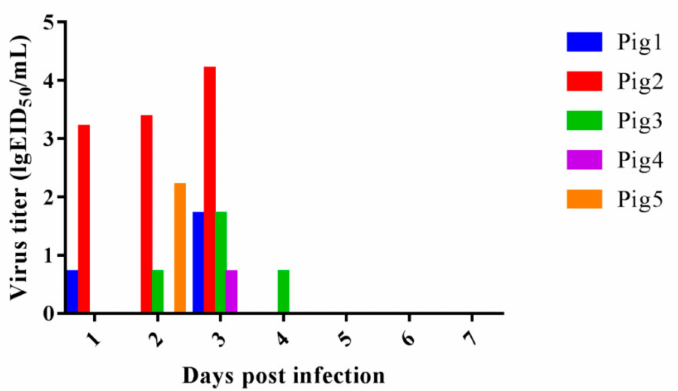
Figure 5. Virus shedding of H9N2 influenza virus in inoculated pigs. Thirteen healthy 3-week-old pigs were randomly divided into three groups. Of these, five pigs were intranasally inoculated with CK93 / 17 at a dose of 10 7 EID 50 in 1 mL as treatment group. Three pigs were intranasally inoculated with 1 mL PBS as control group. One-day post-inoculation (1 dpi), five pigs were housed with treatment pigs as a physical contact group. Nasal wash was collected from all pigs from 1 to 10 dpi and titrated in 9 to 11-day-old embryonated eggs. Two treatment pigs, one contact pig, and one control pig were euthanized at 3 dpi. One treatment pig, two contact pigs, and one control pig were euthanized at 5 dpi. The viral titers in tissues were titrated in 9 to 11-day-old embryonated eggs. Table 4. Seroconversion of pigs inoculated with or exposed to H9N2 influenza viruses.